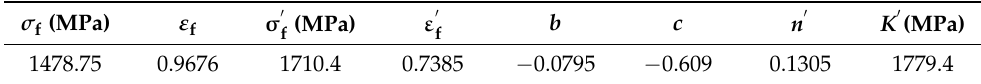
Table 5. Fatigue life prediction parameters of 42CrMo